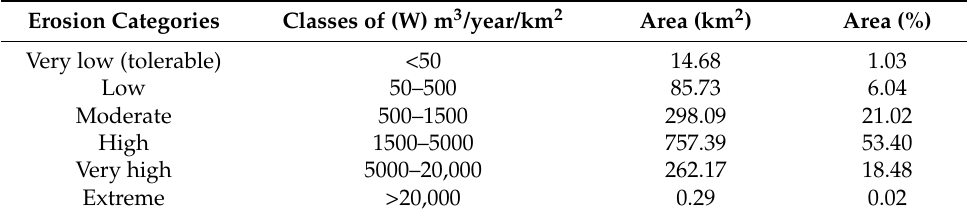
Table 6. Soil loss values in the Tassaoute